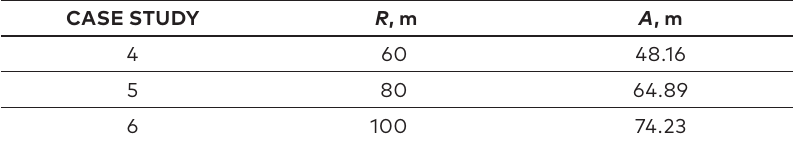
Table 6. Design clothoids: scale factor A